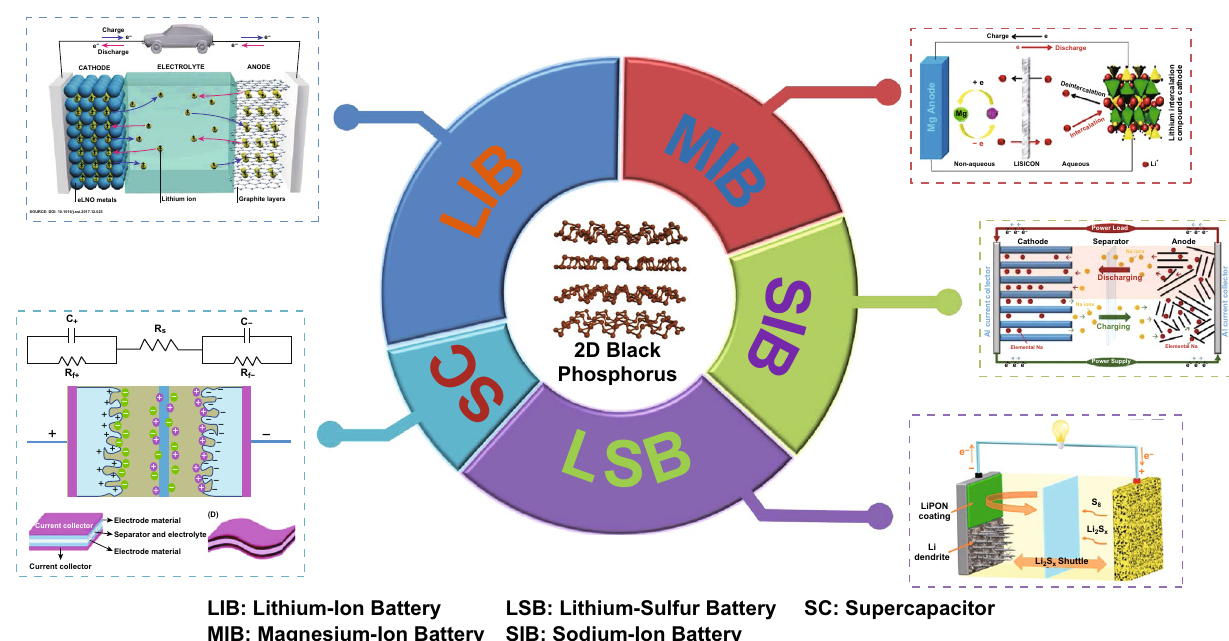
Fig. 6 A summary of the potential applications of 2D BP. The pie chart shows the ratio of publications in each explored application of 2D BP with respect to the total number of publications. LIB image: reprinted with permission from ref [173], Copyright 2018 Elsevier; MIB image: reprinted with permission from ref [171], Copyright 2015 Nature Publishing Group; SIB image: reprinted with permission from ref [202], Copy- right 2015 Elsevier; LSB image: reprinted with permission from Ref. [178], Copyright 2019 Elsevier; SC image: reprinted with permission